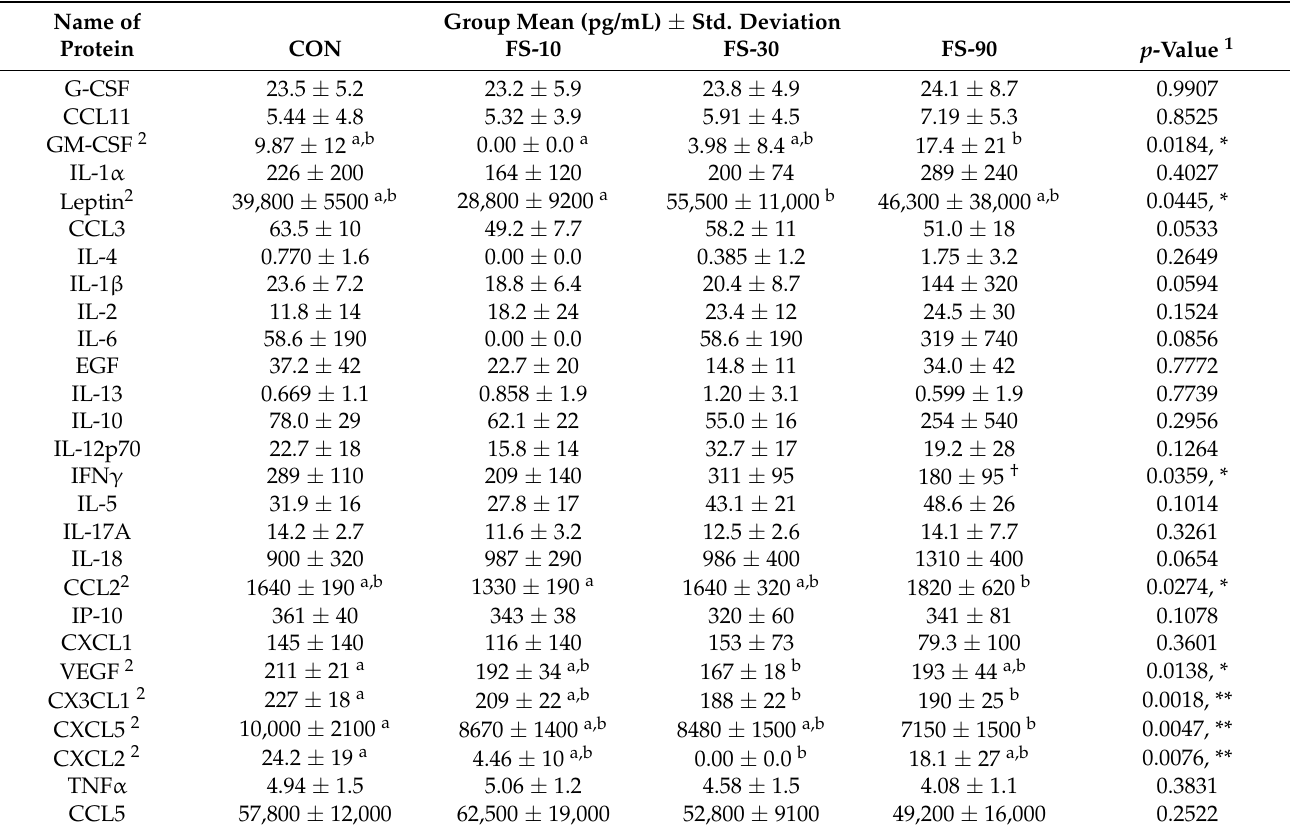
Table 2. Serum cytokine and chemokine protein